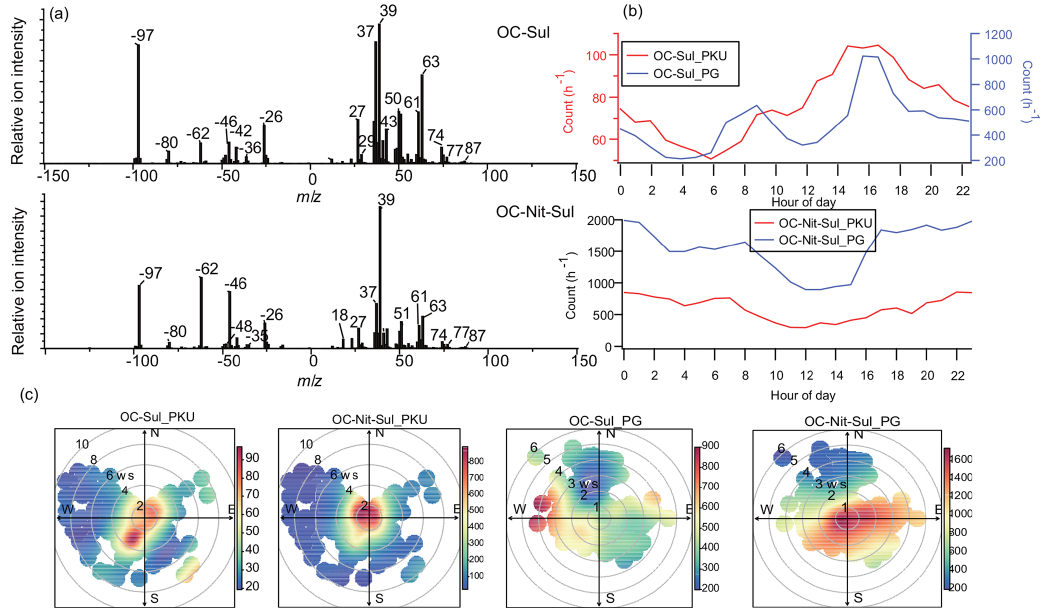
Figure 4. (a) Average mass spectra of OC-Nit and OC-Nit-Sul observed at both sites; (b) diurnal patterns of the hourly count of OC-Nit and OC-Nit-Sul at both sites; (c) polar plots of OC-Sul and OC-Nit-Sul; the gray circles indicate wind speed (ms 1 ).